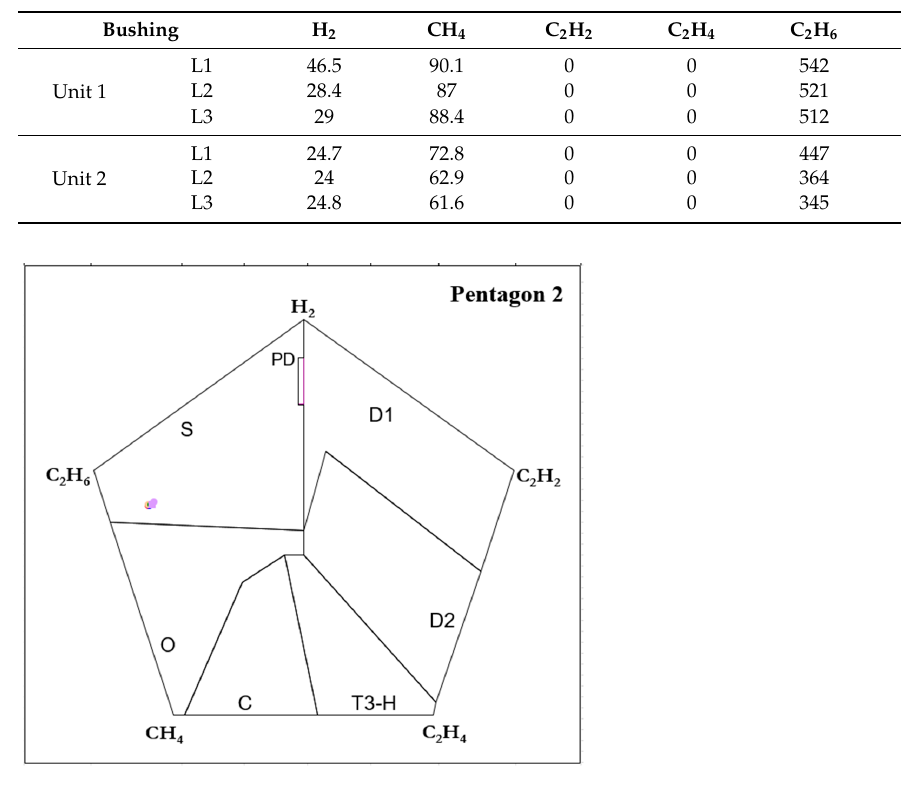
Table 2. SG patterns of DDB oil in bushings of RWE in service (units 1–2).